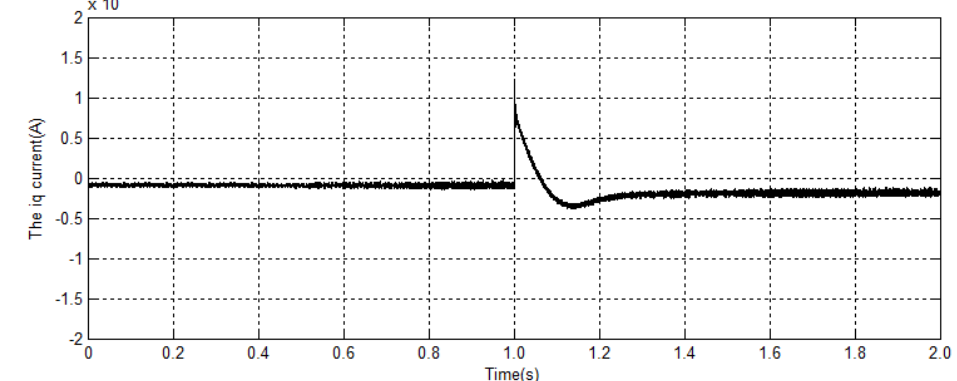
Figure 8. The current simulation curve of the q -axis.